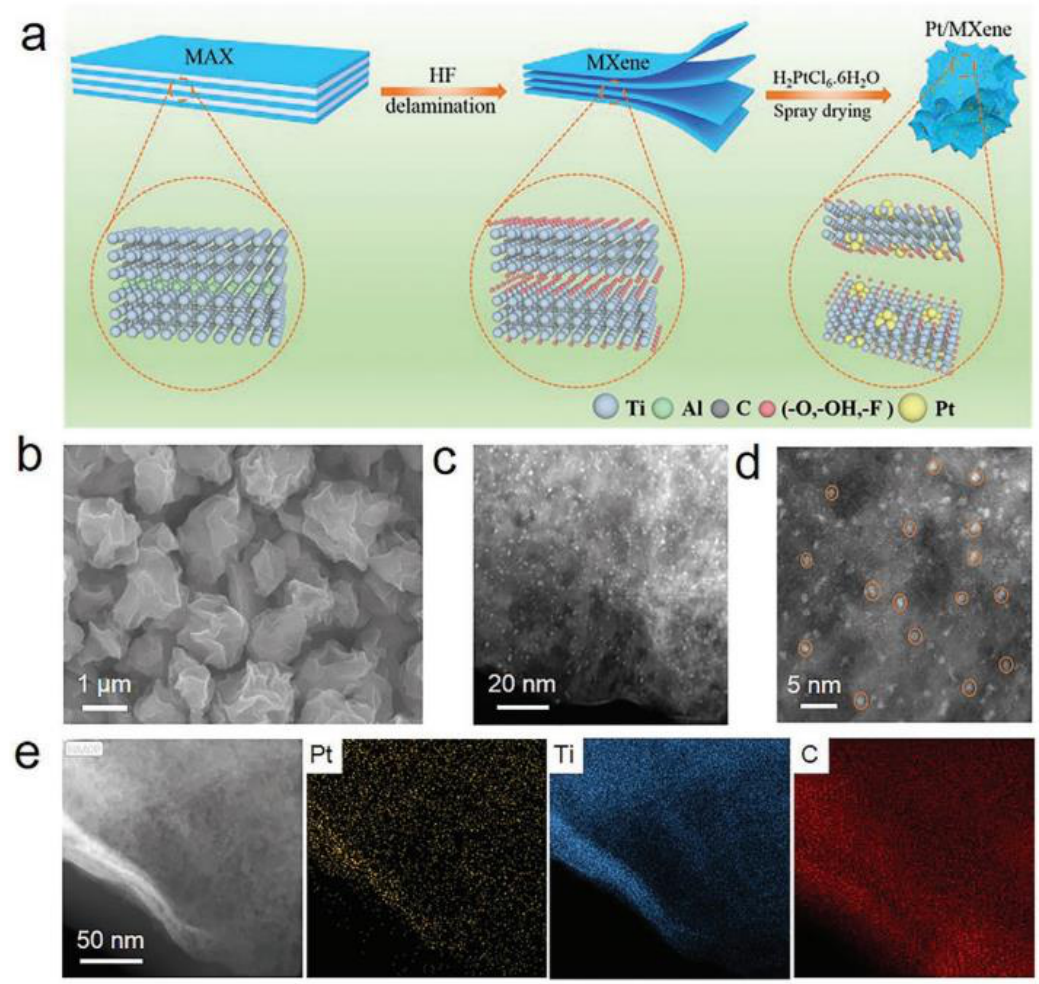
Figure 9. ( a ) Schematic illustration for the preparation of Pt/MXene. ( b ) SEM images of Pt/MXene. ( c , d ) HAADF-STEM images of Pt/MXene and ( e ) the EDX elemental mappings. Adapted with permission from [171], Copyright 2022, John Wiley and Sons.